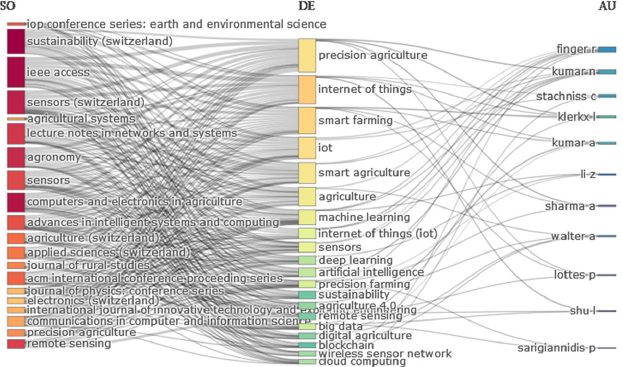
Figure 8. Relationships between sources ( left ), authors’ keywords ( middle ), and authors ( right ). Source: Scopus-Biblioshiny.